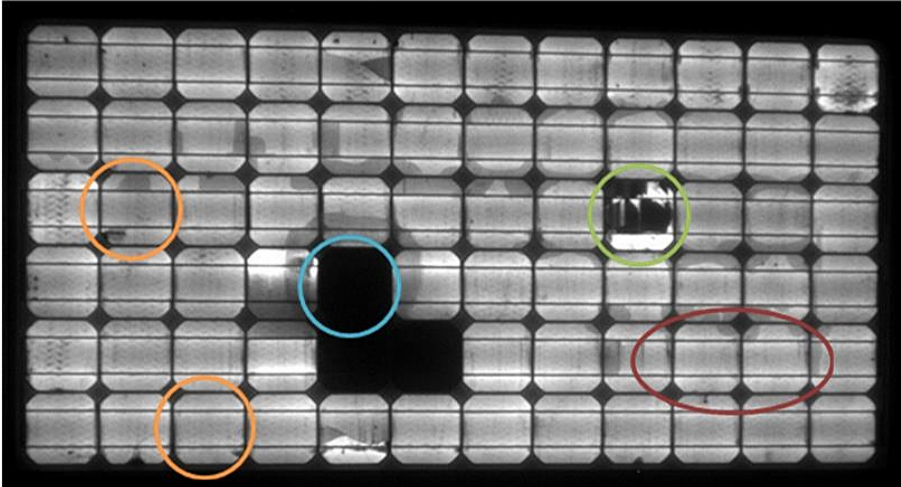
Figure 12. EL image of a the same PV panel, to at I sc , previous to be installed in the plant (indoors and with the use of a power supply). Capture made with the camera fixed on a